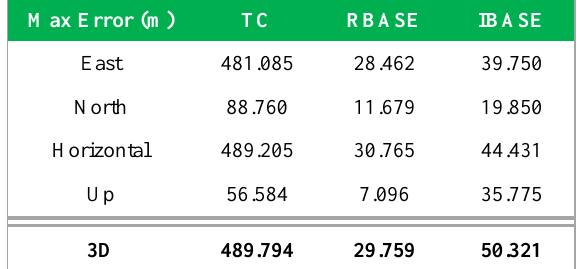
Table 2. Max error of TC RBASE and IBASE scheme